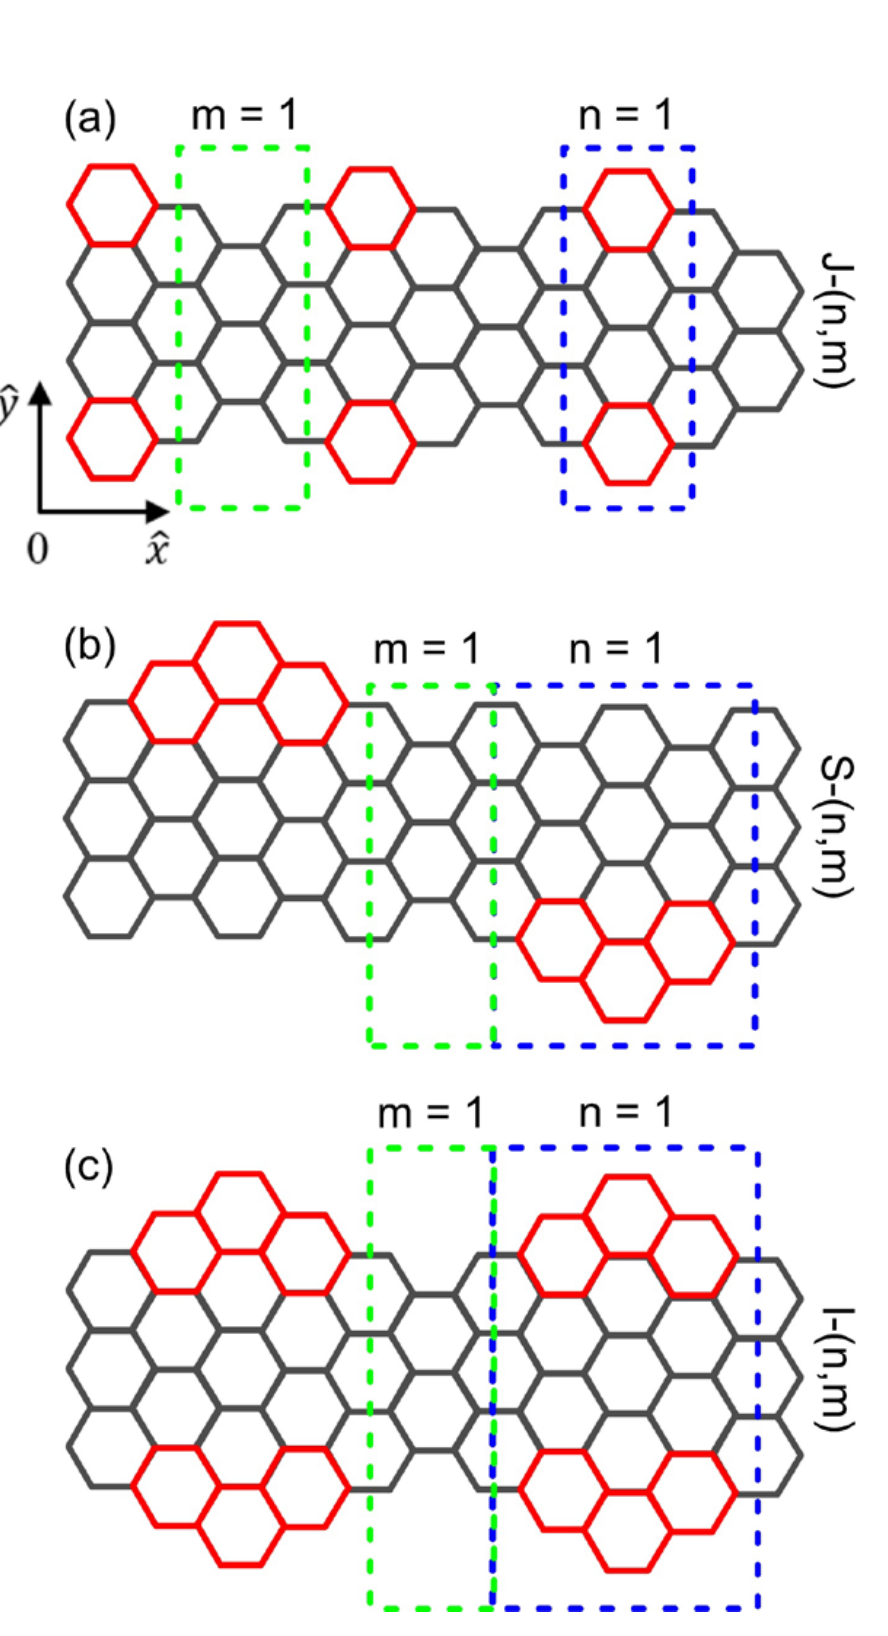
Figure 1. (color online) Lattice structures of edge-extended AGNRs for ( a ) 7/9-AGNR nanoribbon, ( b ) staggered edge-extended AGNR, and ( c ) inline edge-extended AGNR. The grey hexagons denote pristine AGNRs while the red hexagons represent the edge-extended areas. The green and blue dashed rectangles indicate the units of n and m segments,